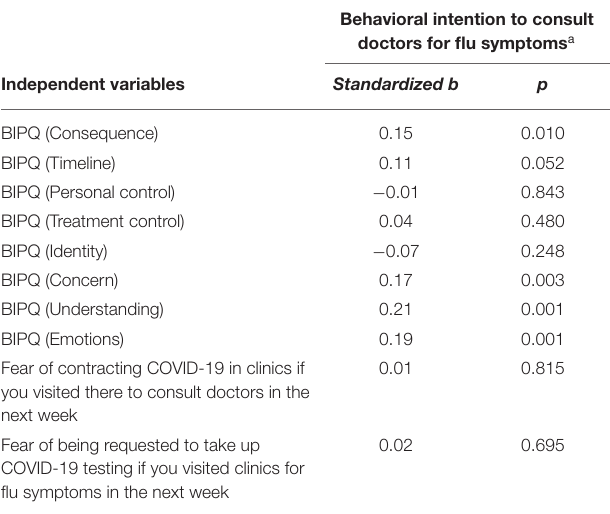
TABLE 4 | Associations between illness representations of COVID-19, fear of COVID-19 during clinic visits, and the behavioral intention to consult doctors for flu symptoms ( N =